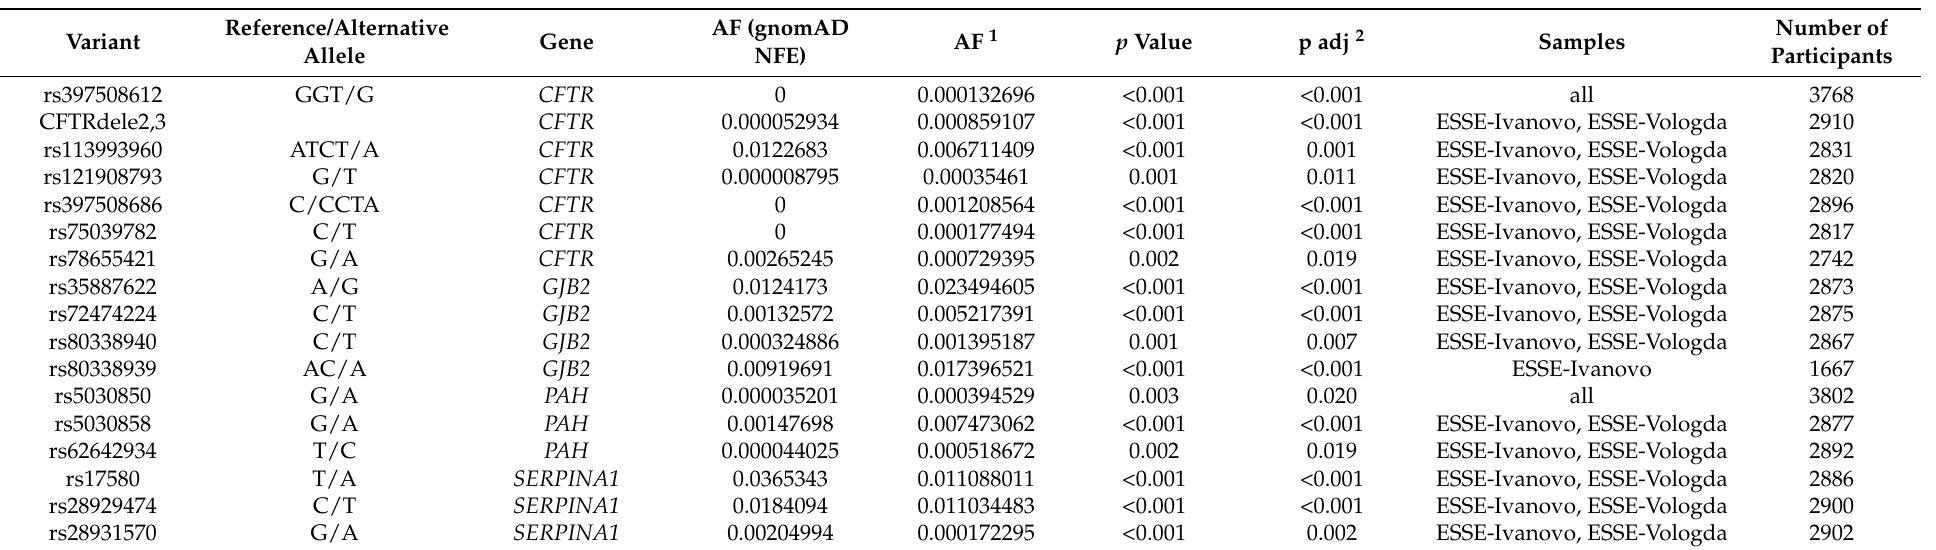
Table 4. Variants with significant differences in AF between studied samples and NFE data.